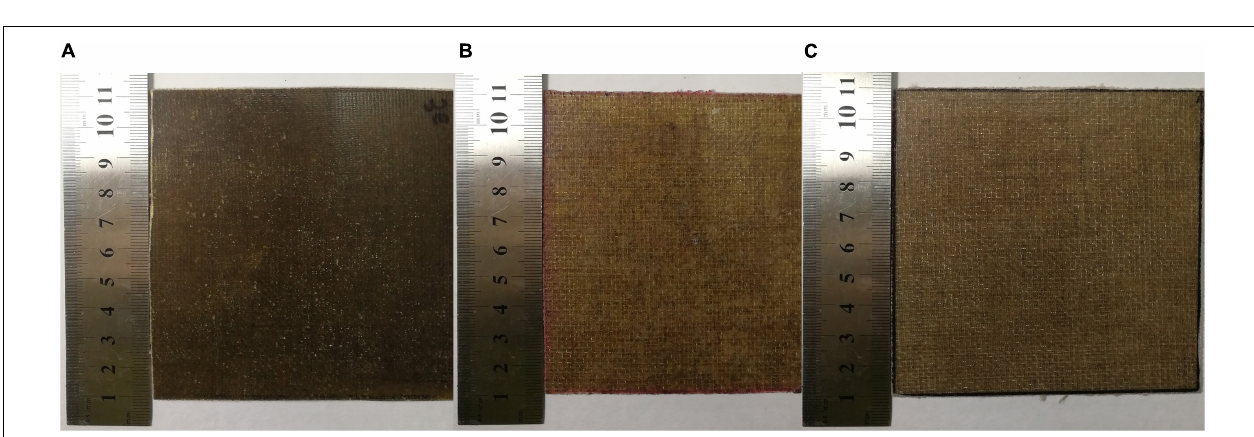
FIGURE 3 | Testing samples; (A) flax composite, (B) flax with an embedded wire mesh, and (C) flax with an outer-ply wire mesh.